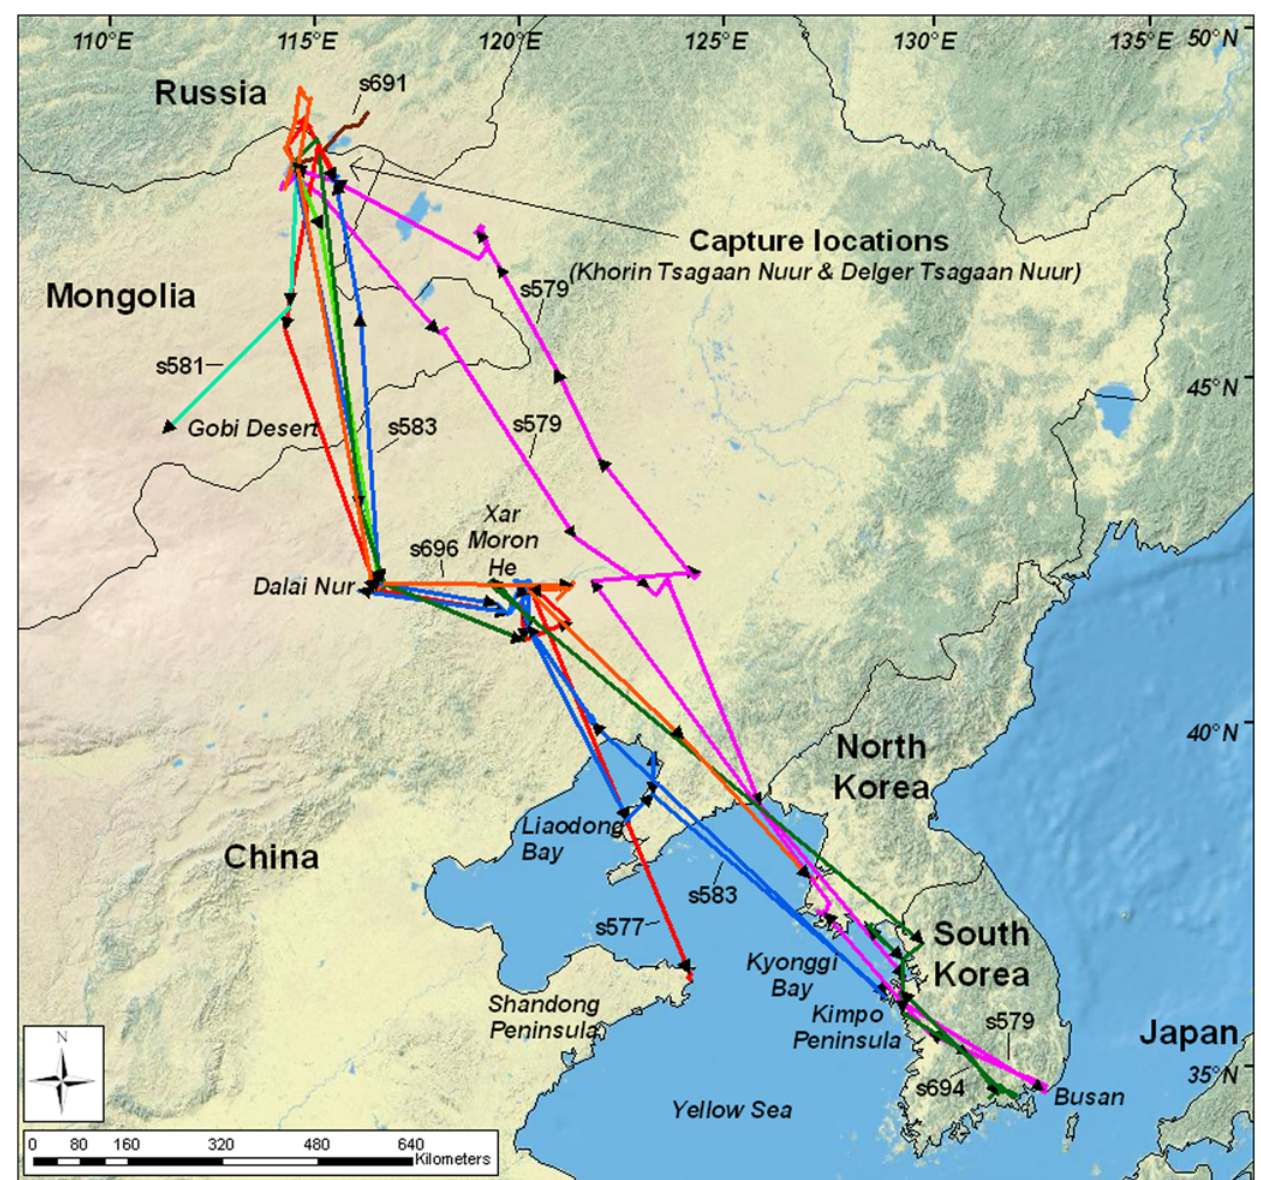
Figure 1. Map of the study area including satellite transmitter-marked whooper swan migratory routes.